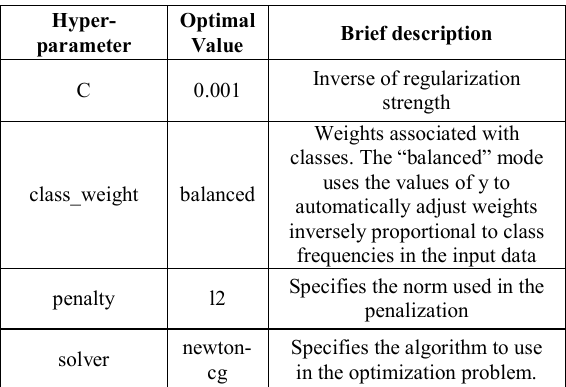
Table 4. Optimal hyperparameters for Binary Logistic Regression.